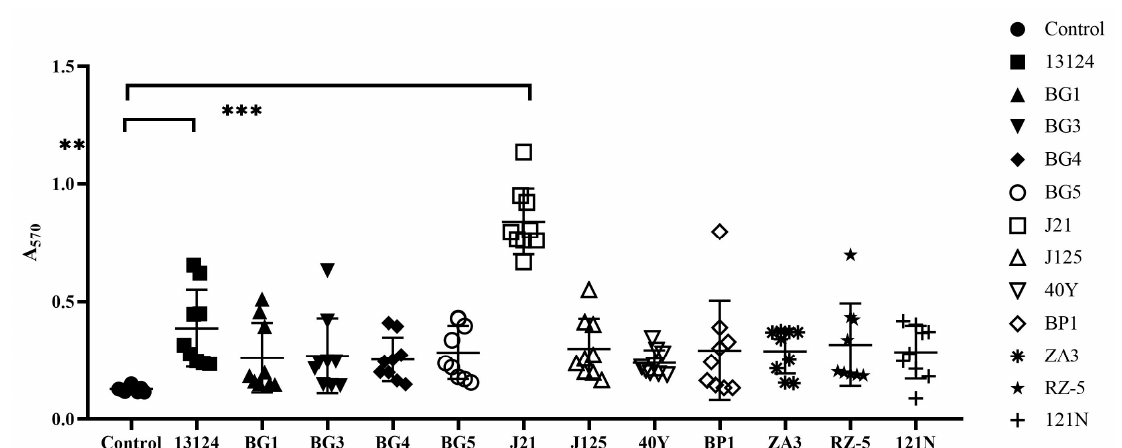
Figure 4. Biofilm formation by C. perfringens isolates after incubation at 37 °C for 3 days. Strains were selected from different origins. Each dot represents nine replicates for each strain. The bars represent the mean values of each group. The p values were calculated using a linear model for unequal variances. The A 570 comparison between different groups was performed using an independent two-sample t-test. Asterisks represent significant differences between different groups (** p < 0.01, *** p < 0.001).